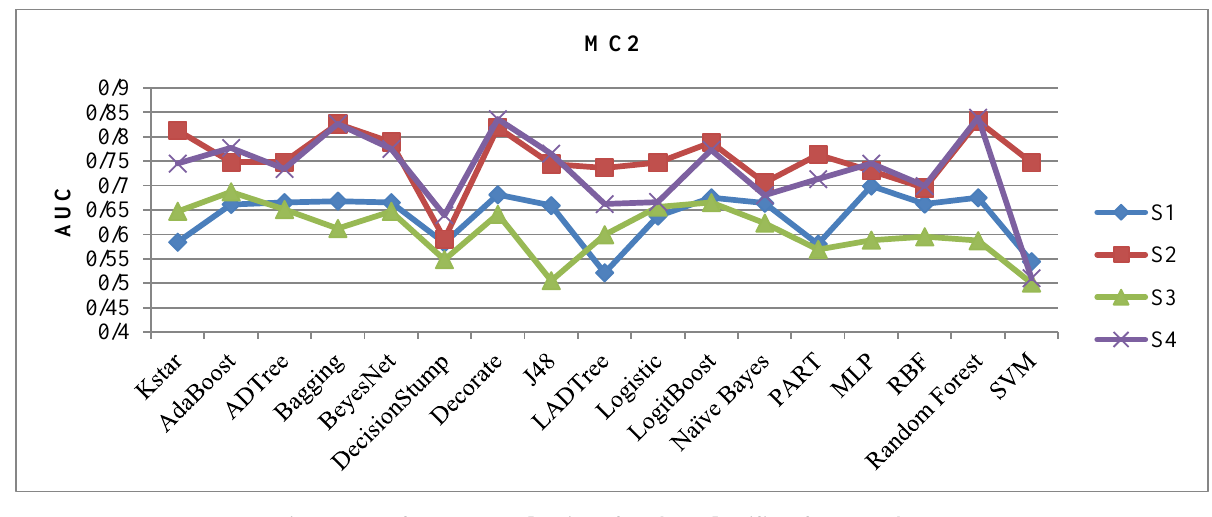
Figure 4. Performance evaluation of 17 data classifiers for MC2 dataset.